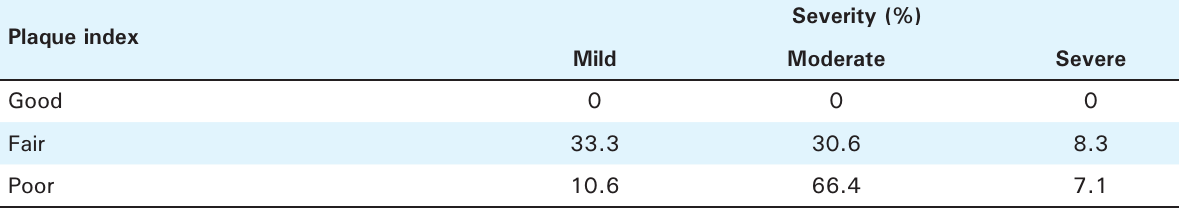
Table 4. Relation between plaque index and drugs